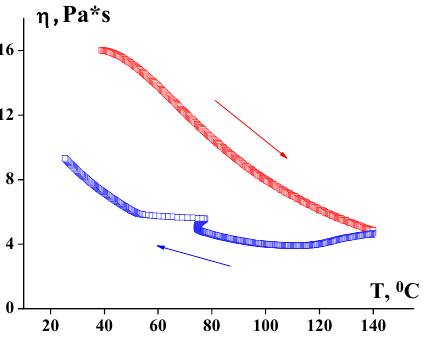
Figure 28. Thixotropy at temperature scanning for 4% solution of PABI in dimethylacetamide.